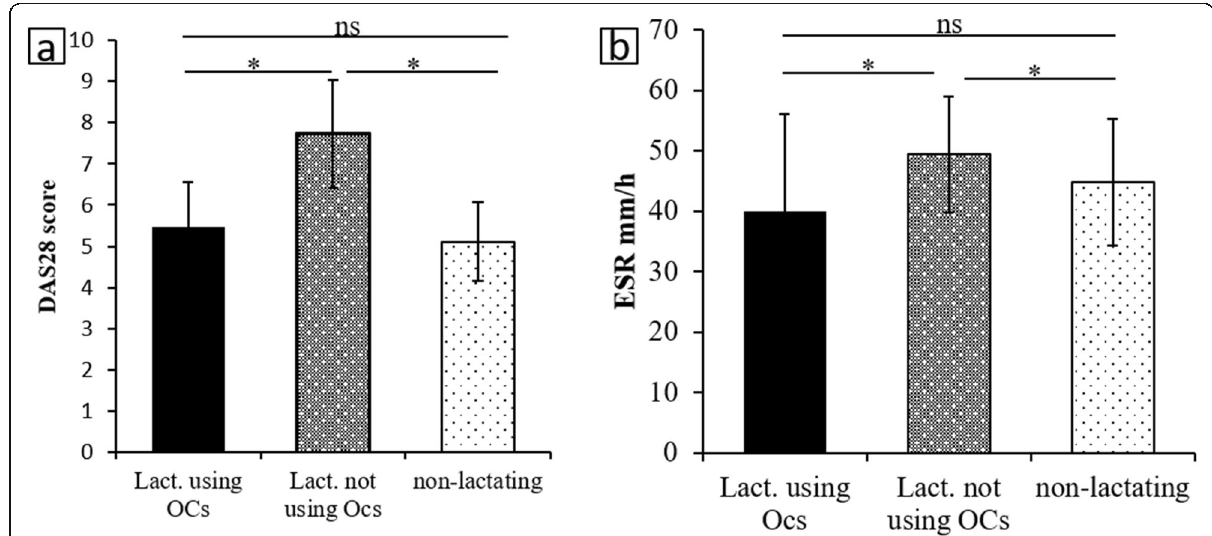
Fig. 3 Effect of using oral contraceptives during lactation on DAS28 score and ESR. a DAS28 score. b ESR, data presented as mean ± SD, ns = insignificant difference, * significant difference at p <